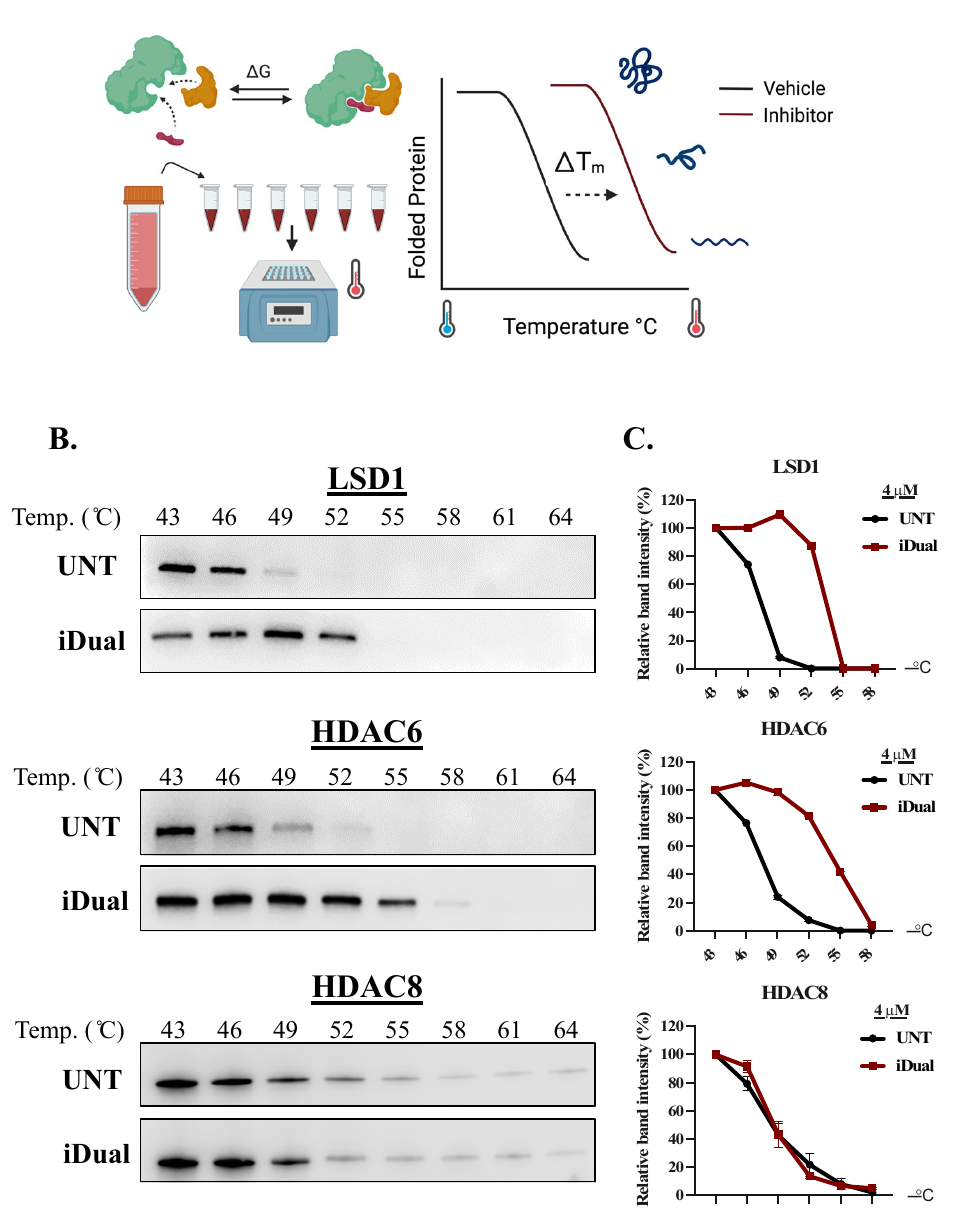
Figure 2. iDual is a dual inhibitor targeting LSD1, HDAC6, and HDAC8. ( A ) Cellular thermal shift assay (CETSA) experimental procedure was generated in BioRender.com. ( B ) Drug and target engagement and protein stabilization results via CETSA. LSD1 and HDAC6/8 enzymes in THP-1 cells treated with DMSO (untreated, UNT) or the dual inhibitor iDual (4 µ M, 1 h). Full Western blot images can be found in Figure S28. ( C ) Relative band intensities quantified using Image J software and indicated graphically for LSD1, HDAC6, and HDAC8.